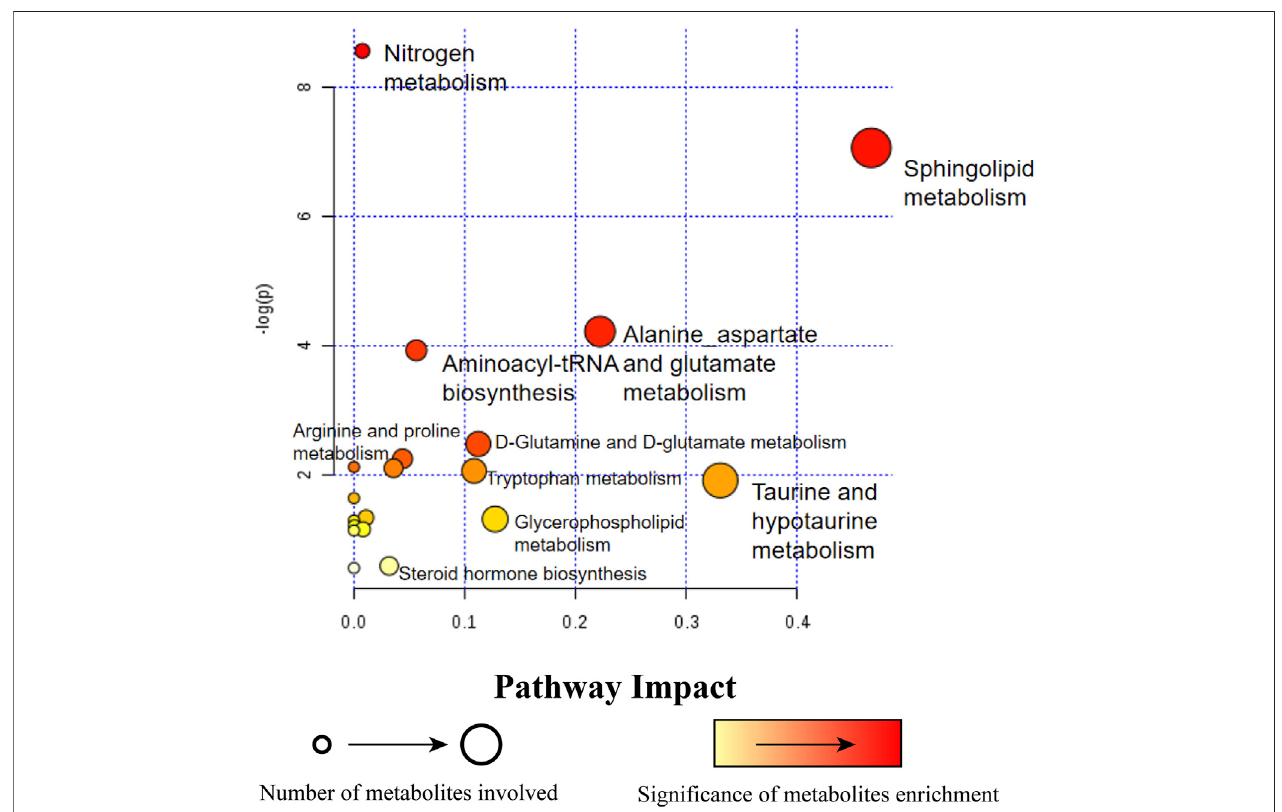
FIGURE 6 | Pathway enrichment analysis of 44 metabolites. A circle with a bigger diagram means more metabolites are in volved in this pathway. Circle in light yellow ( ) is regarded as a lower signi fi cance than those in red ( ).